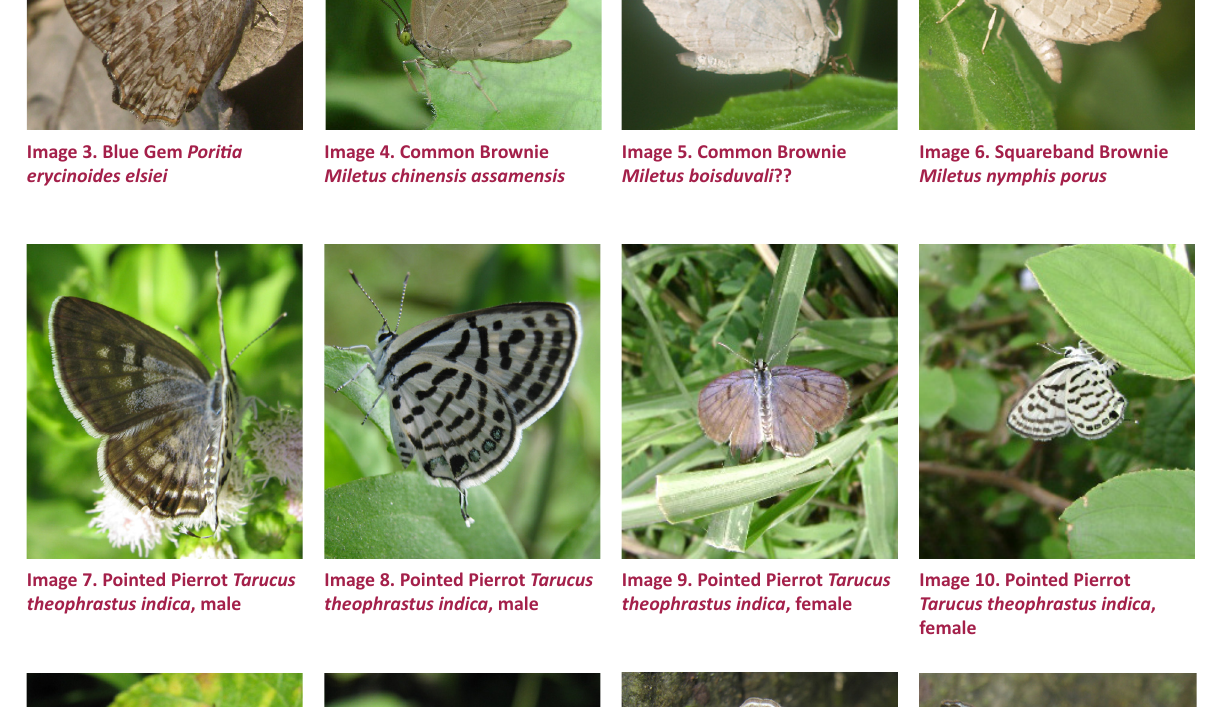
Image 7. Pointed Pierrot Tarucus theophrastus indica , male